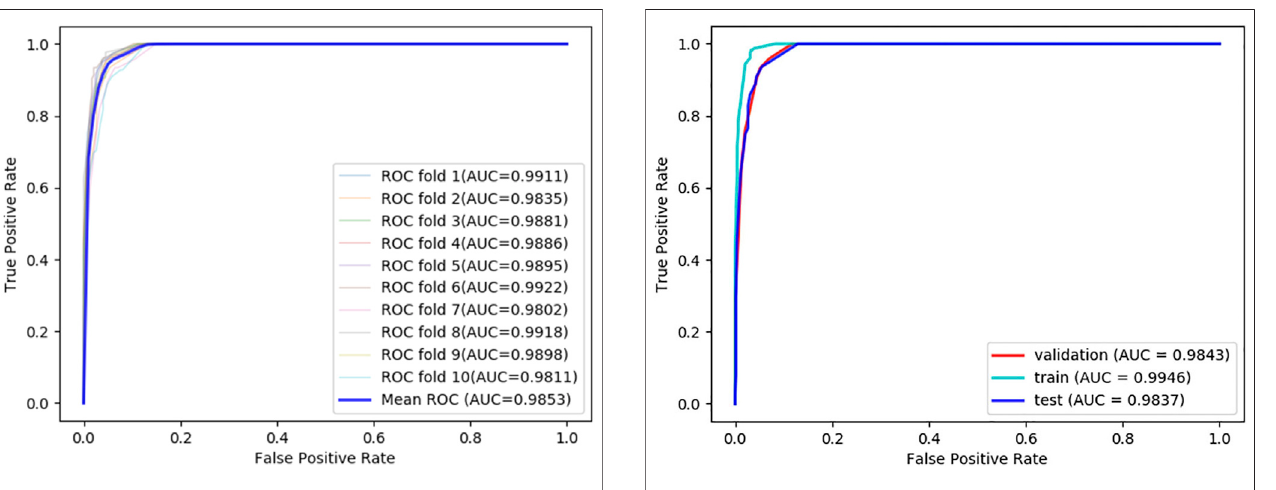
FIGURE3| ROCcurves ofLDA-EAGCN indifferentsituations of10-fold cross-validations.